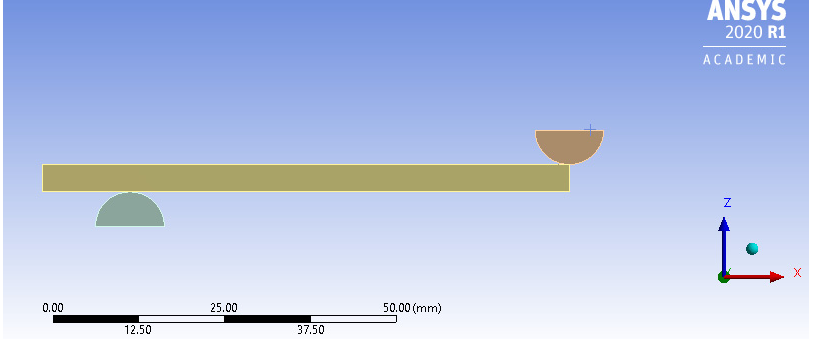
Figure 2. Quarter symmetry model geometry.